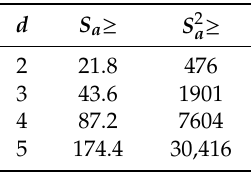
Table 2. The relationship between the numbers of downsampling and the size of the anchor box.